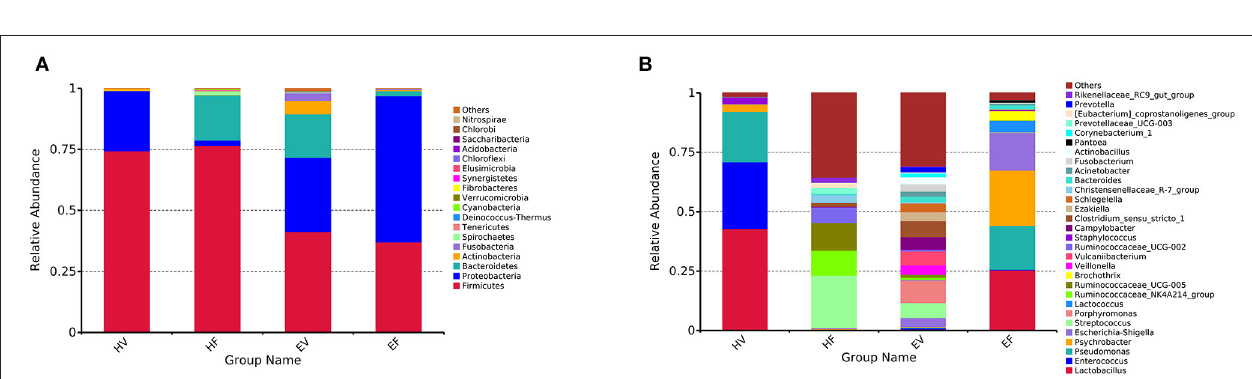
FIGURE 2 | Principal coordinate analysis (PCoA) shows bacterial community structures based on Bray–Curtis distances . On the PCoA plot, each symbol represents one gut microbiome. (A) Unweighted UniFrac distance of the intestinal and vaginal sample microbiota; (B) weighted UniFrac distance of the intestinal and vaginal sample microbiota. The numbers of PC1 and PC2 show the percent variation explained by the PCoA plot.